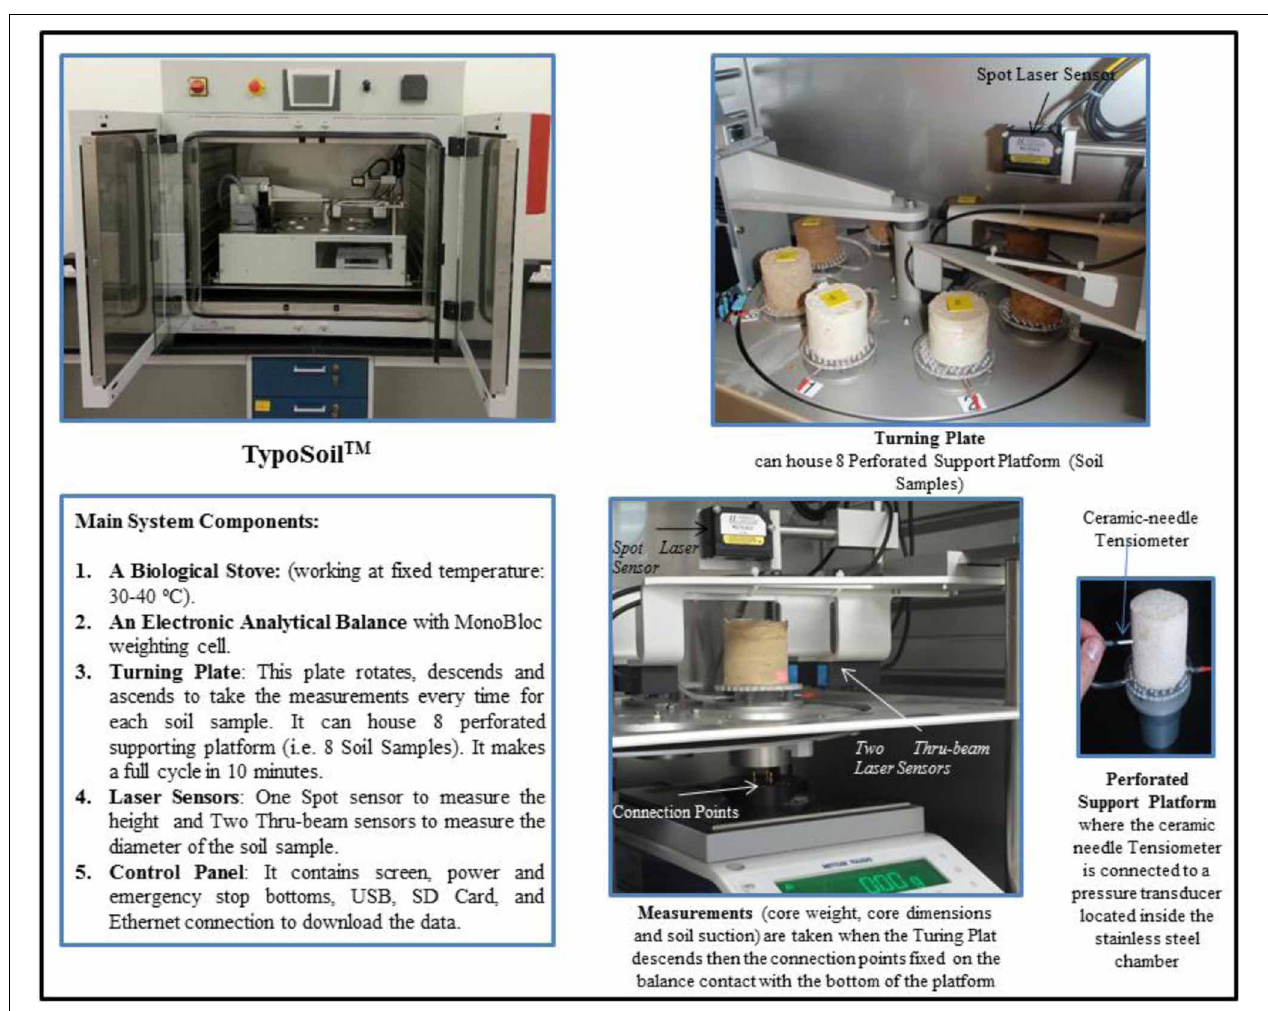
FIGURE 3 | TypoSoil™ with its main components and how they function to measure continuously and simultaneously the soil weight (by a balance), soil suction (by a porous ceramic cup mini